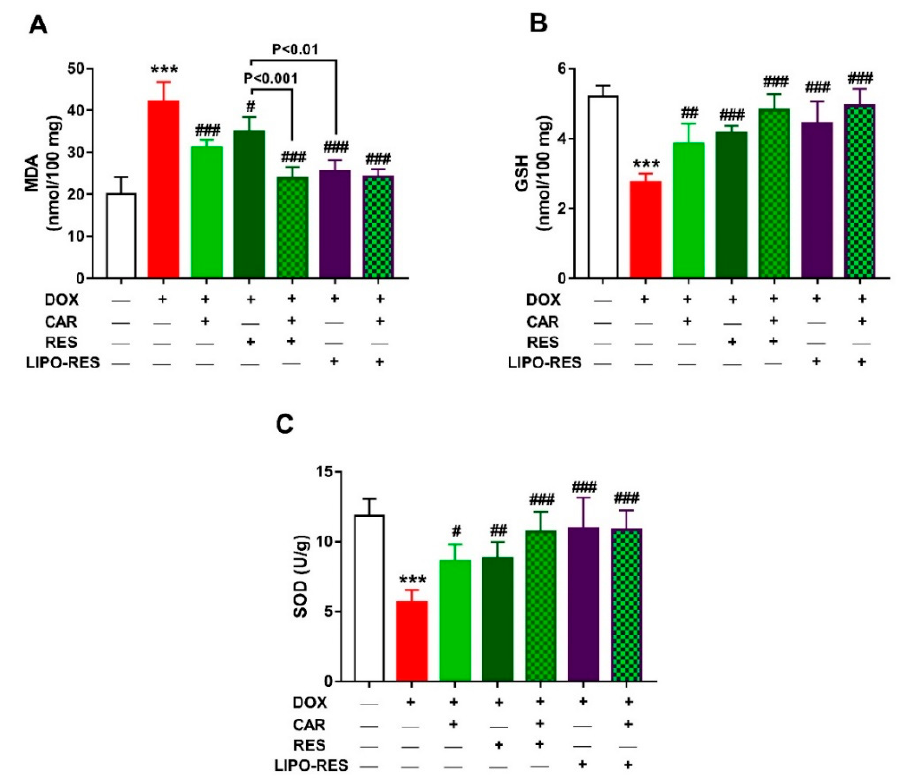
Figure 6. CAR and/or RES and LIPO-RES decrease cardiac MDA ( A ) and increase GSH ( B ) and SOD ( C ) in DOX-intoxicated rats. Data are expressed as mean ± SEM, ( n = 6). *** p < 0.001 versus Control. # p < 0.05, ## p < 0.01 and ### p < 0.001 versus DOX.